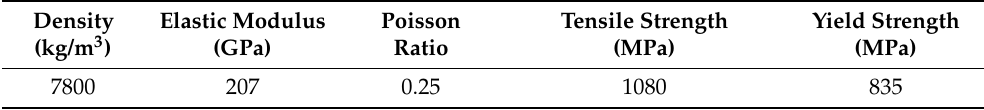
Table 3. The mechanical properties of 20CrMnTi.